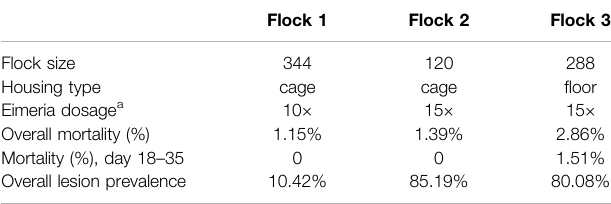
TABLE 3 | Mortality and intestinal lesion prevalence in three experimental fl ocks with different fl ock sizes, housing types, and coccidiosis challenge intensities. Coccidial pre-exposure was incorporated in the NE disease model through oral gavage of live Eimeria oocysts using the Coccivac-B52 vaccine (Merck Animal